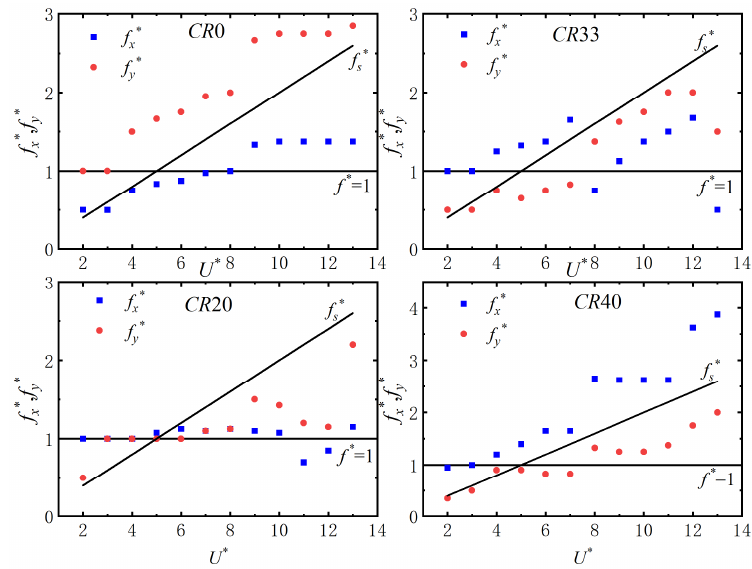
Figure 19. Vibration frequency of bulged cylinder with different coverage ratios.